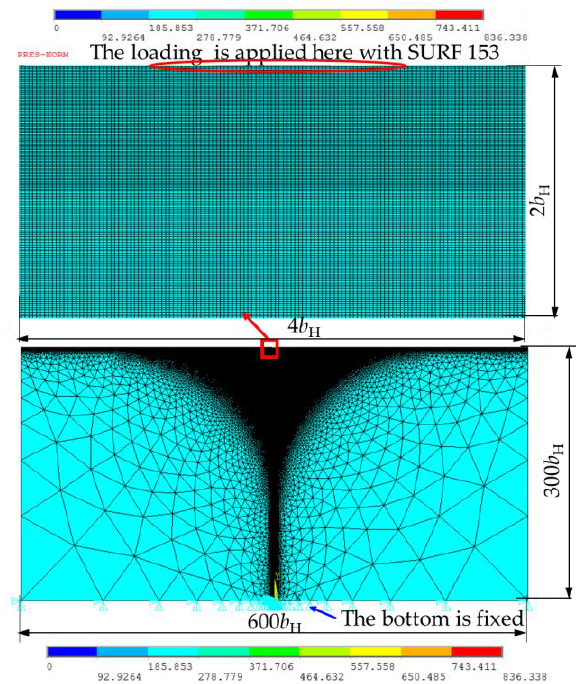
Figure 3. The illustration of the FEM model of the multilayered solid subjected to surface mechanical loading.